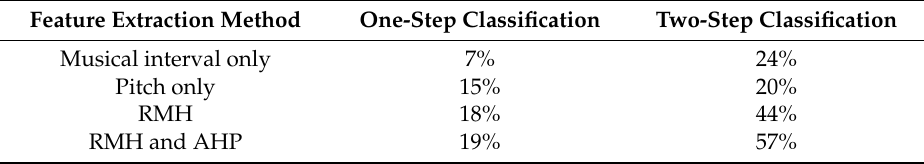
Table 6. Comparison of classification accuracy of one-step and two-step